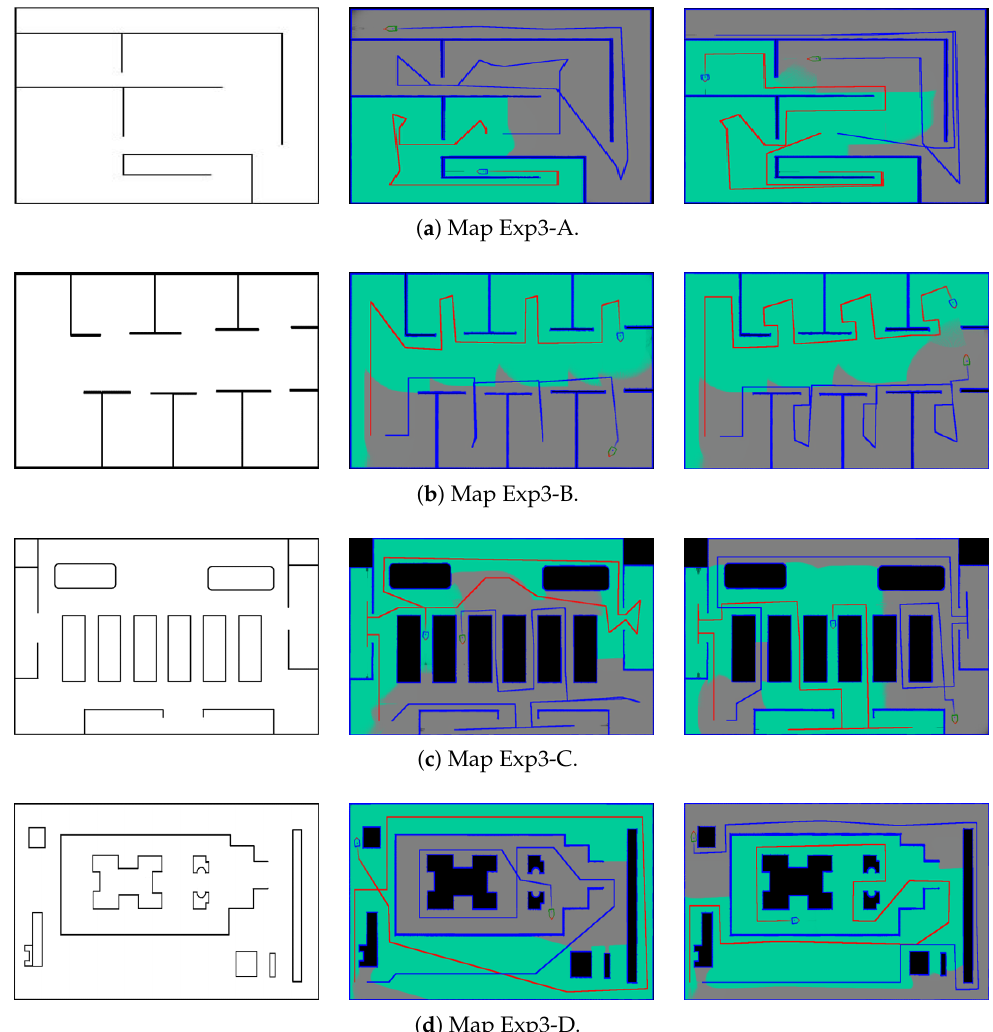
Figure 8. The complete coverage results of the multi-robot exploration using our technique and the algorithm proposed by Pereira et al. [33]. From the left to the right: the original maps, the coverage results using our technique, the coverage results using Pereira’s